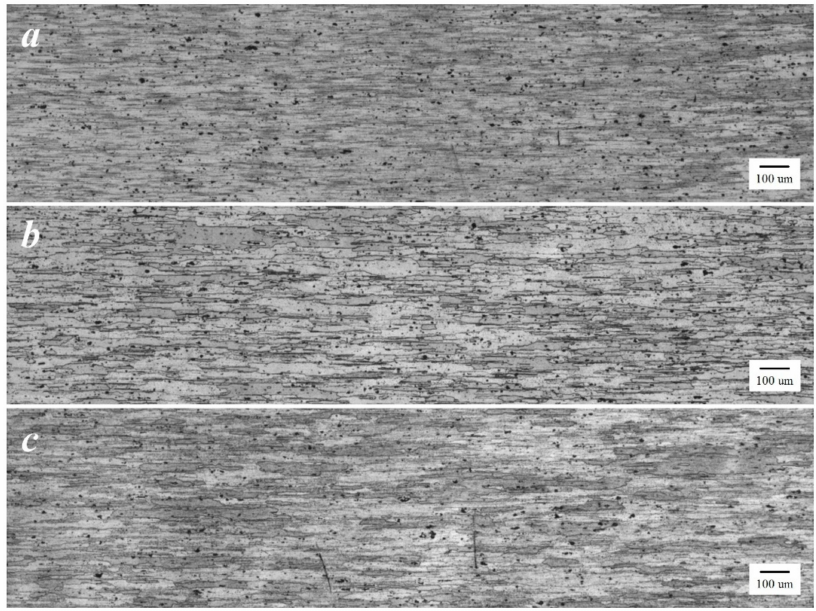
Figure 15. Microstructure of base material (BM) at 50 × ( a ) FSW; ( b ) FSW-DR-PWHT; and ( c ) FSW-PWHT-DR.